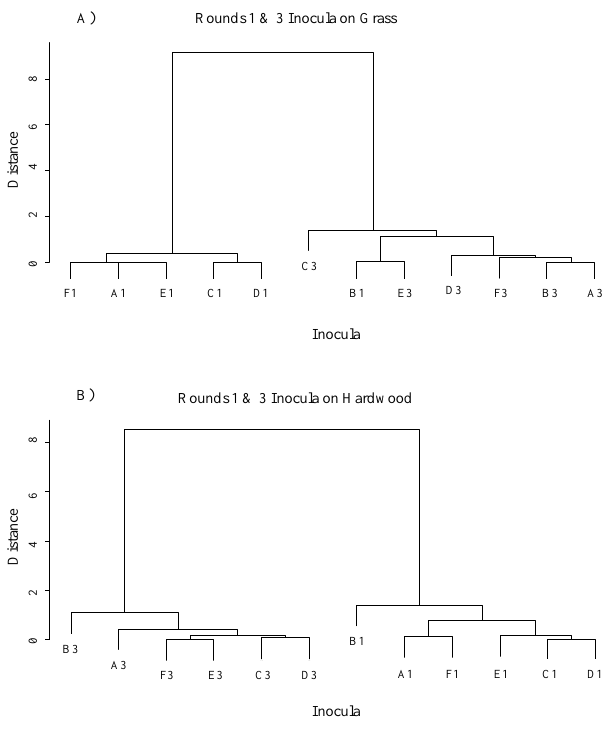
Fig. 2. Cluster diagrams, using Euclidean distance and Ward’s method, for cumulative litter decomposition rates for inocula with a history of grass (A) or hardwood litter environments (B) in rounds 1 and 3. For both the grass and hardwood litter environments, func- tioning across inocula is approximately equal within rounds, indi- cating that functional dissimilarity is maintained across time.